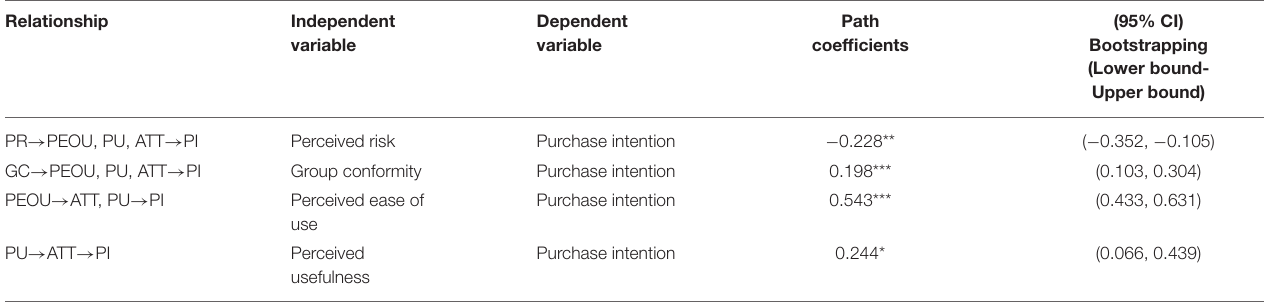
TABLE 7 | Bootstrapping indirect